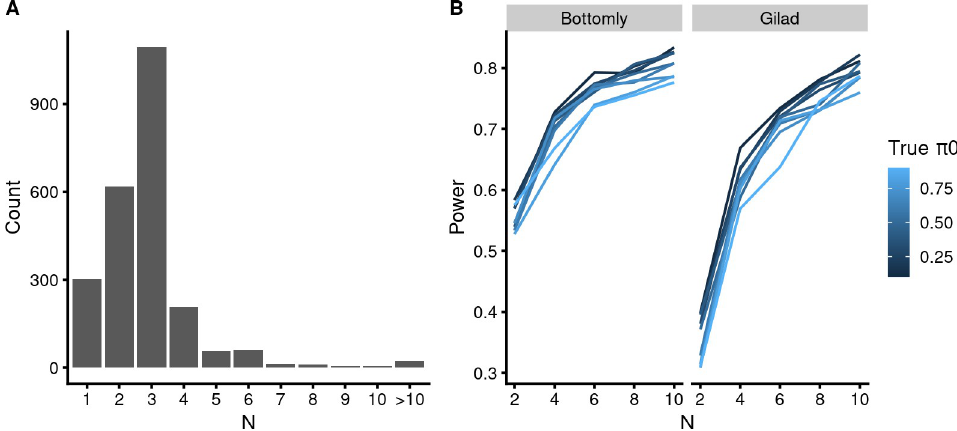
Fig 4. The sample sizes of HT-seq DE experiments indicate low power. ( A ) Histogram of 2,393 sample sizes. The data file is in S7 Data. ( B ) Statistical power simulations using different π 0 settings (shown as shades of blue coloring) and 2 different biological variation settings (“Gilad” corresponds to human liver samples and “Bottomly” to inbred mice; [33]). The data file is in S8